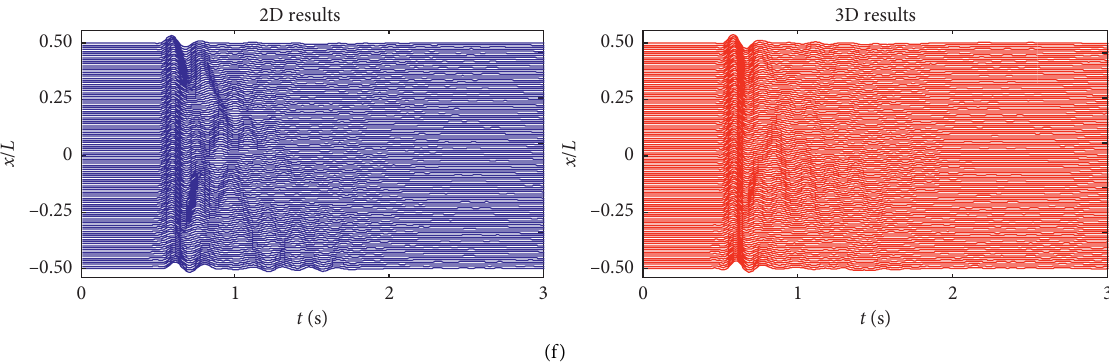
Figure 8: Waveforms on the reef flat calculated by 2D and 3D Zhubi Reef models: (a) Slice 1; (b) Slice 2; (c) Slice 3; (d) Slice 4; (e) Slice 5 (f) Slice